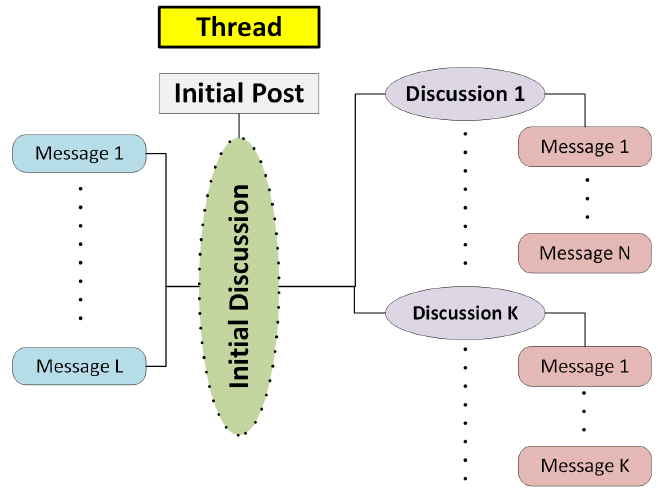
Figure 4. Typical Thread